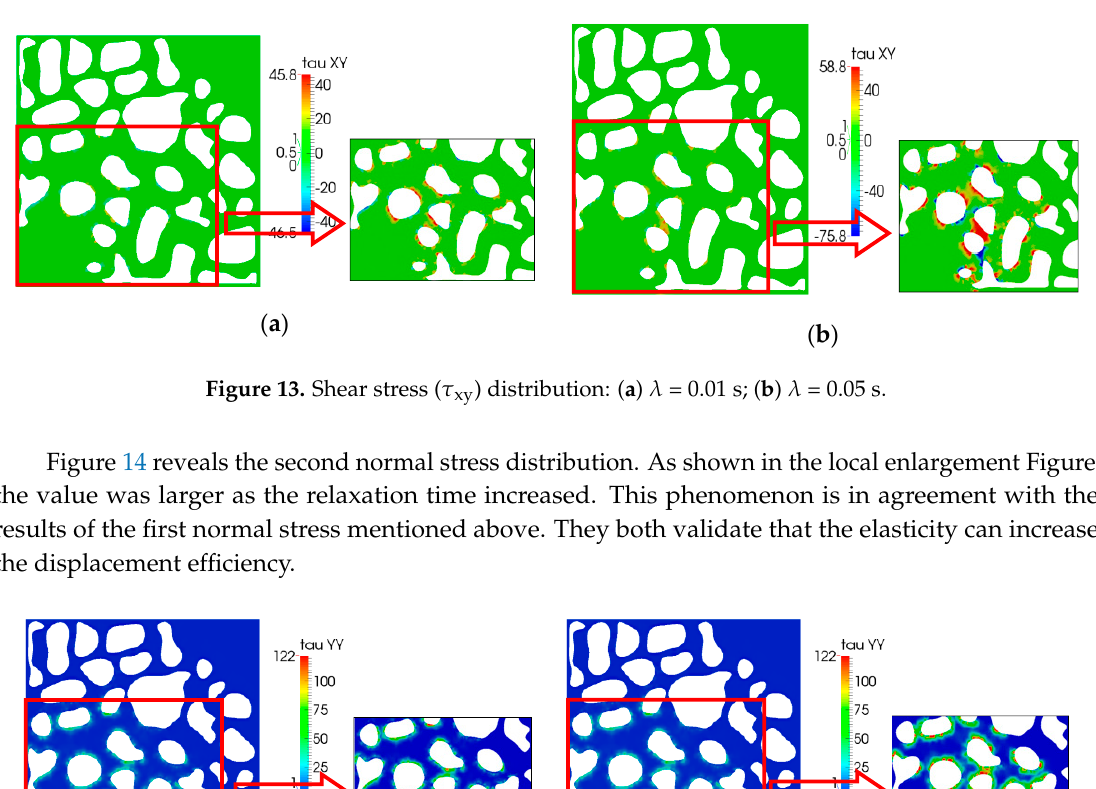
Figure 12. First normal stress ( τ xx ) distribution: ( a ) λ = 0.01 s; ( b ) λ = 0.05 s.